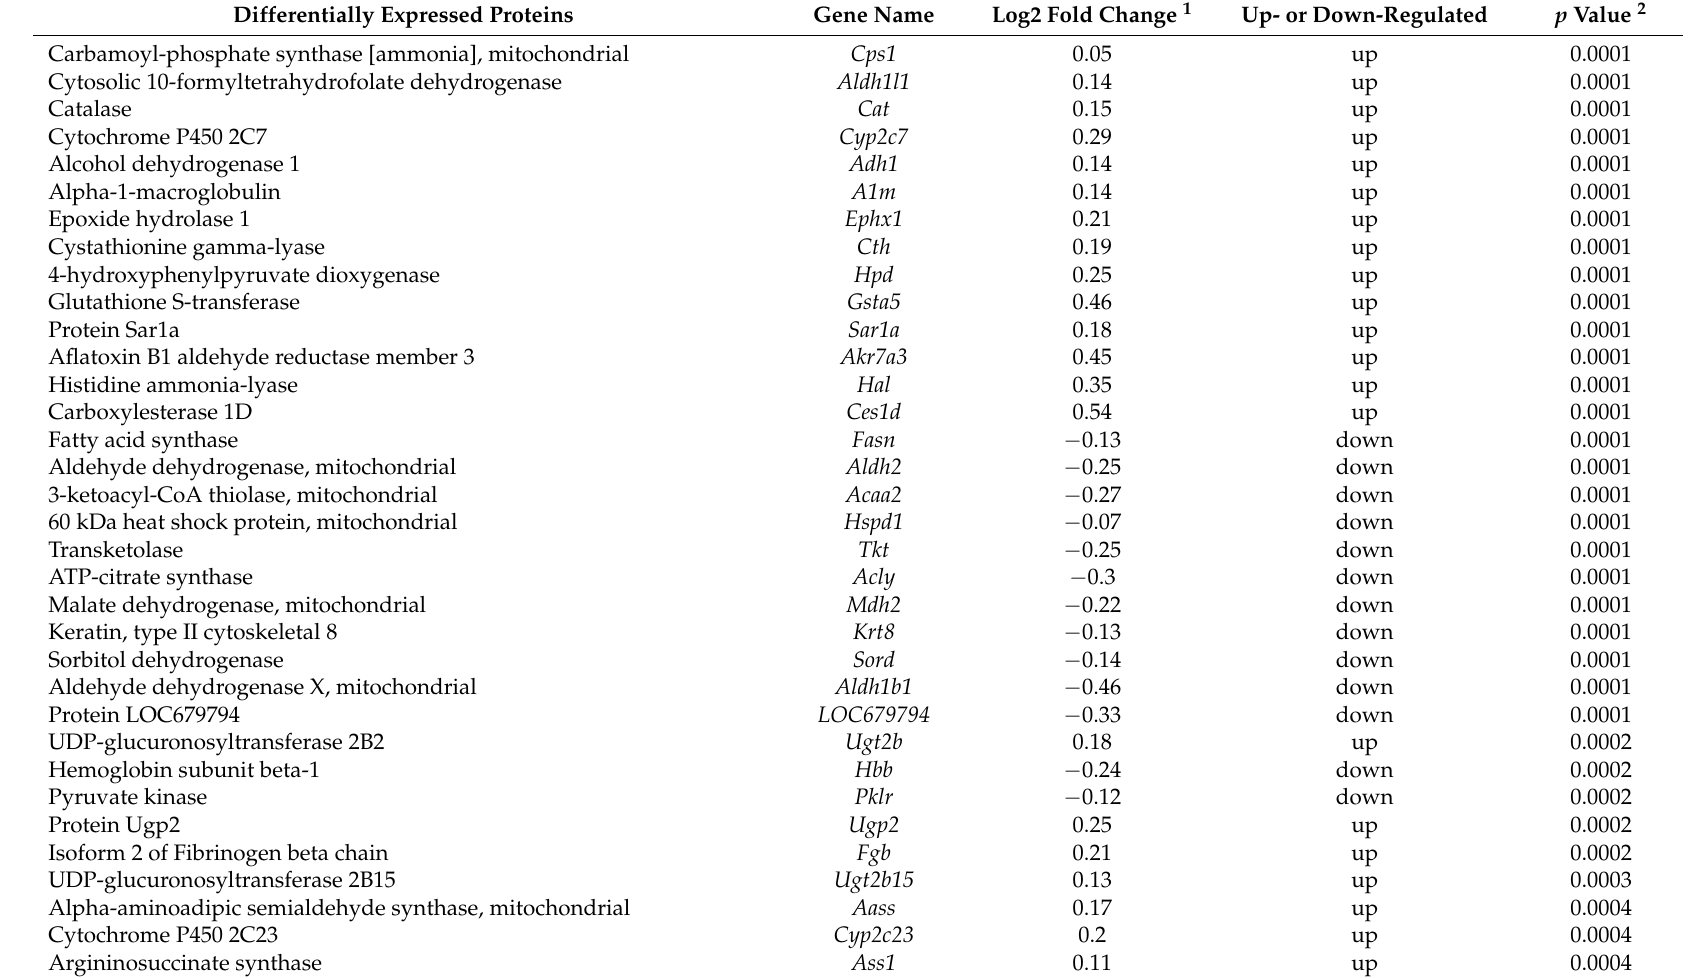
Table 7. Differentially expressed proteins with the Purple Carrots diet in